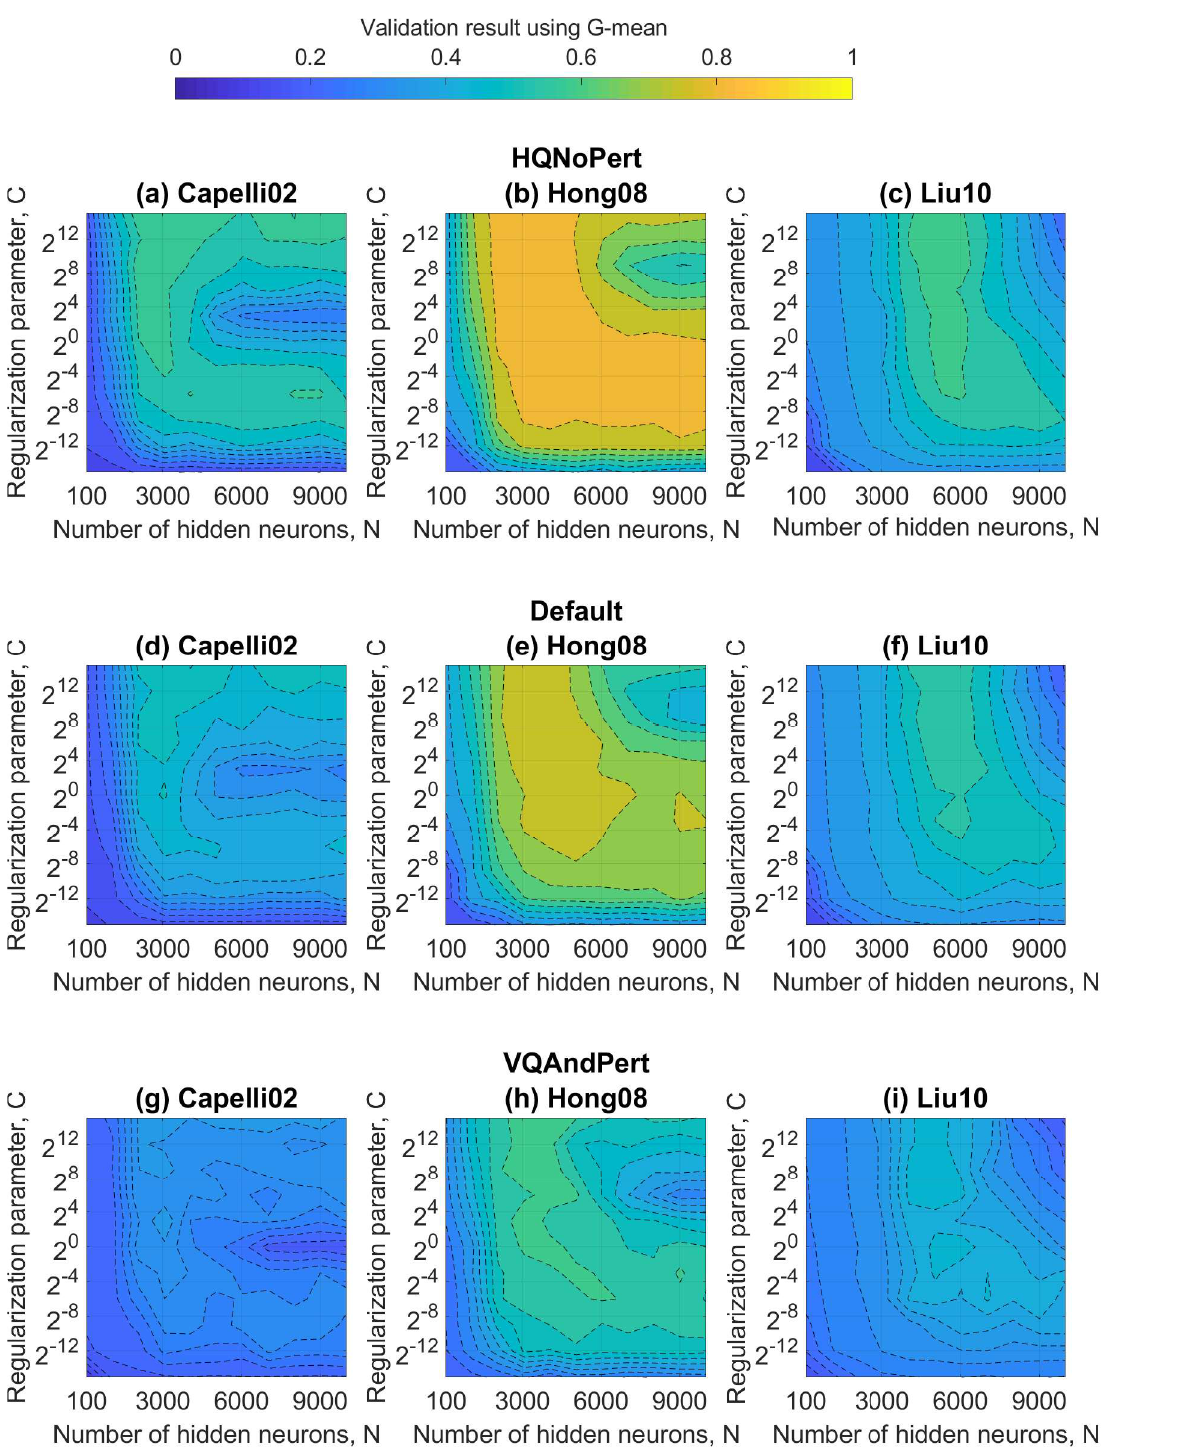
Figure 6. Validation results obtained by the standard ELM as a function of the regularization parameter and number of hidden neurons. Each subfigure illustrates the database and feature